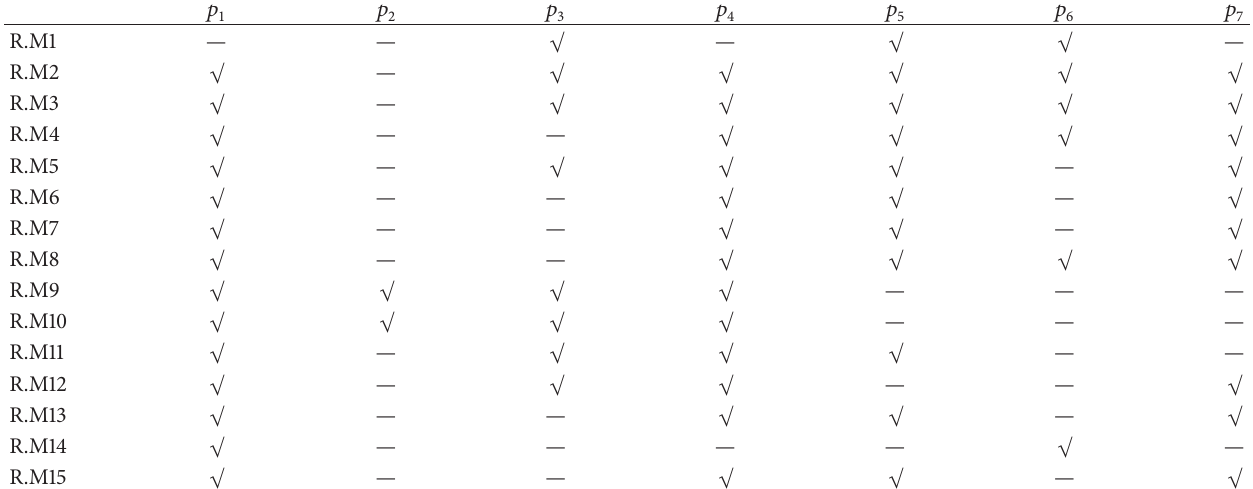
Table 2: Matrix of